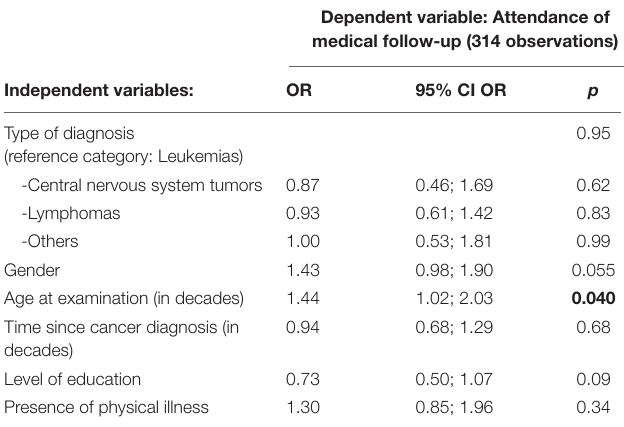
TABLE 2 | Results of the simultaneous logistic regression model of medical follow-up